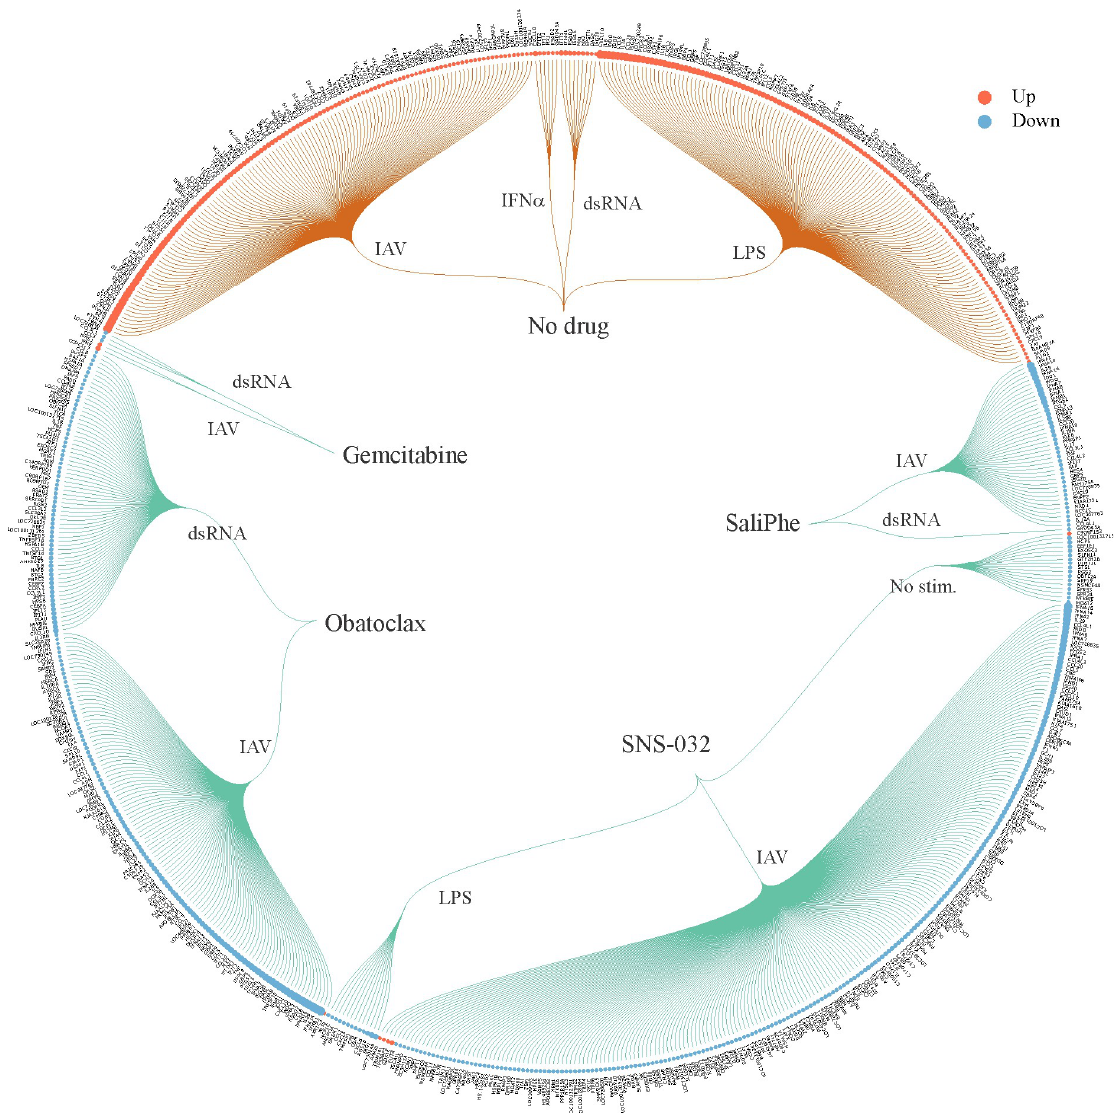
Figure 3. SaliPhe, SNS-032, obatoclax and gemcitabine differentially affect transcription of immune-related genes in stimulated human PBMC-derived macrophages. The macrophages were treated with 3 μM SaliPhe, 0.1 μM SNS-032, 2 μM obatoclax, 1 μM gemcitabine or remained non-treated and infected with IAV (moi 1), or stimulated with 1 μg/mL dsRNA, 1 μg/mL LPS, 1 U/mL IFN-α, or remained non-stimulated. After 8 h, cells were collected; total RNA was extracted and subjected to genome-wide gene expression analysis. Genes, which relative expression levels were up- or down-regulated (log 2 FC (stimulus_no drug–mock_no drug) > 3 and <−3) in response to stimuli in drug non-treated cells, are indicated with orange curves. Genes, which relative expression levels were up- or down-regulated in response to drug treatment in stimulated cells, are shown with green curves (log 2 FC (stimulus_drug–stimulus_no drug) > 3 and <−3). The size of the red and blue circles corresponds to fold changes in expression levels of genes.